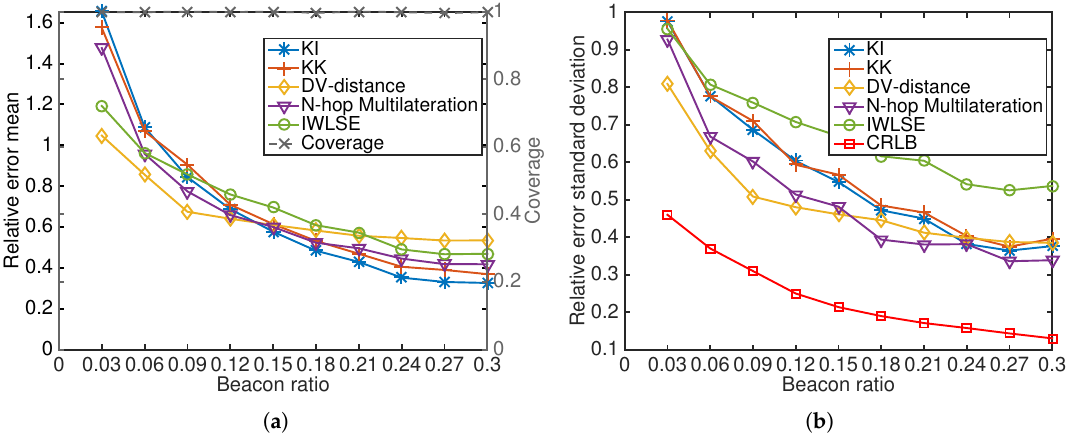
Figure 12. ( a ) Average estimation error and coverage, ( b ) SD as a result of changing the beacon to total nodes